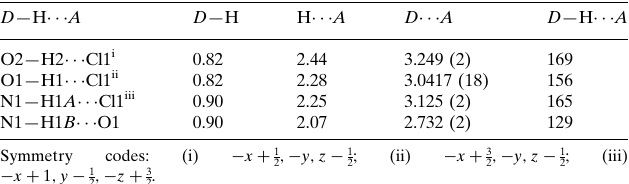
Hydrogen-bond geometry (A˚ , (cid:3)